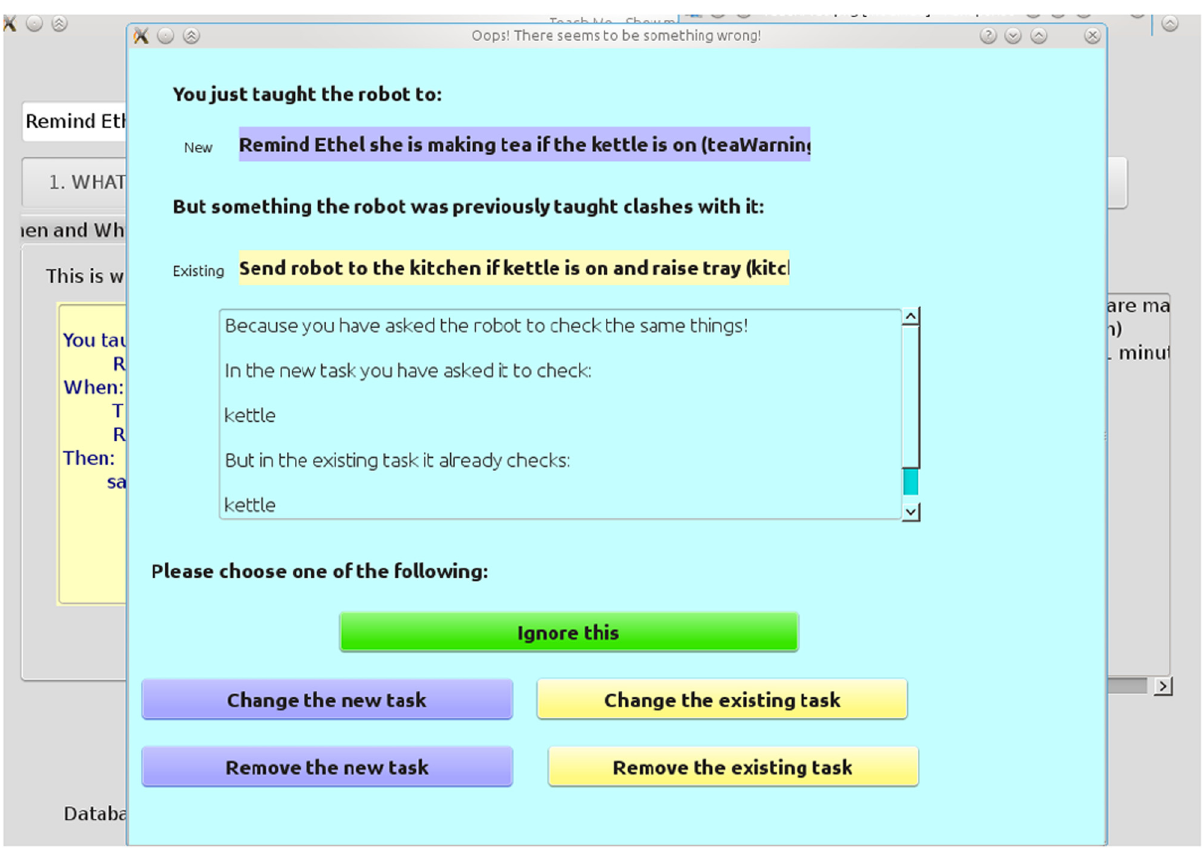
Figure 6: Screenshots of the TEACH M E teaching interface. The system detects a possible interference between two behaviours and asks the user to take action to resolve